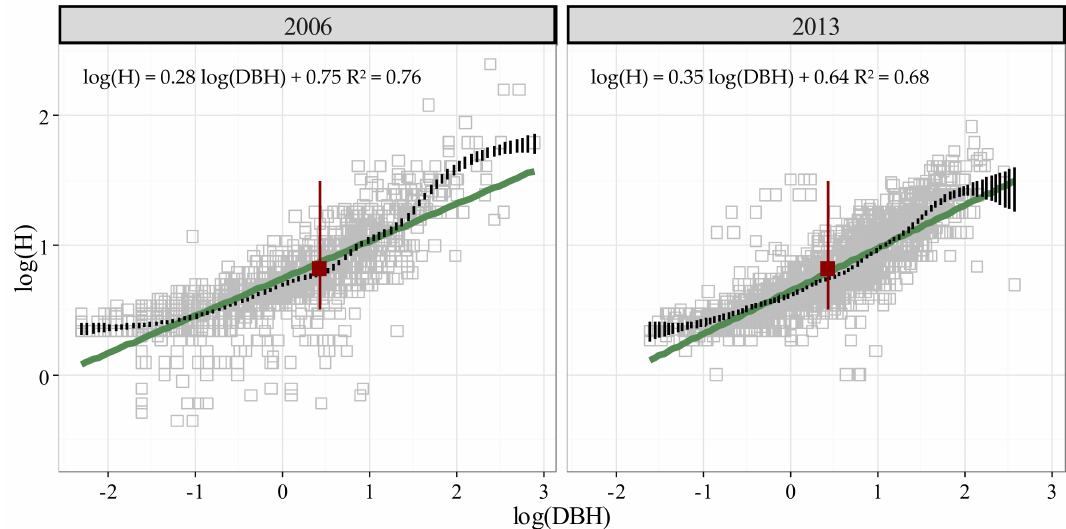
Figure 2. Stature change of treeline birch from 2006 to 2013. The value of b increased from 0.28 in 2006 to 0.35 in 2013, indicating that tree stature became more tapered. Green lines represent results fitted by the linear model; dotted black curves are smoothing splines. Breakpoints (dark red) were detected through the piece-wise regression method (H = 2.25 m for both